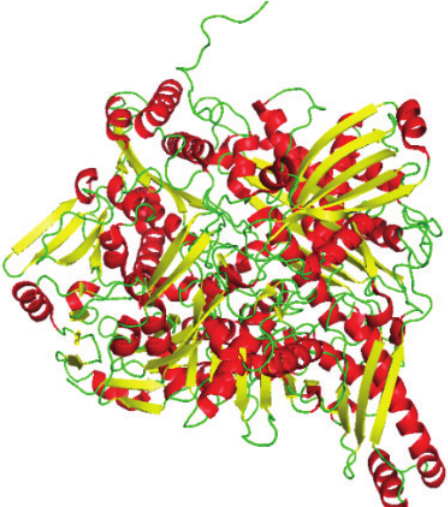
Figure 2. The tertiary structure of the created model of XO (PDB: 1v97) (Okamoto et al. 2004). The structures of α-helix, β-sheet, and turn are presented by cartoon models’ red, yellow, and green